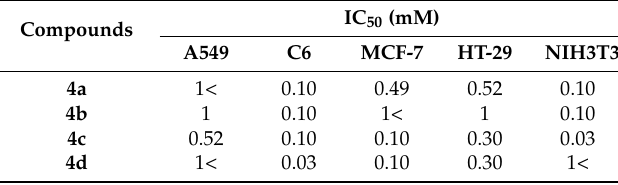
Table 1. Cytotoxic activity of the compounds against A549, C6, MCF-7, HT-29 and NIH3T3 cell